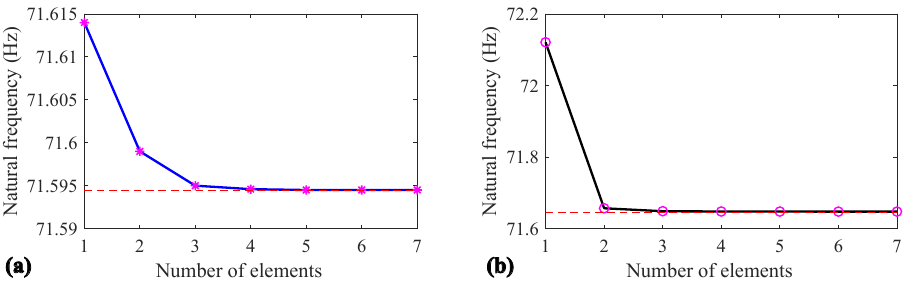
Figure 17. Convergence study of the ANCF model. ( a ) Natural frequency convergence of the main tether; ( b ) natural frequency convergence of the tethered